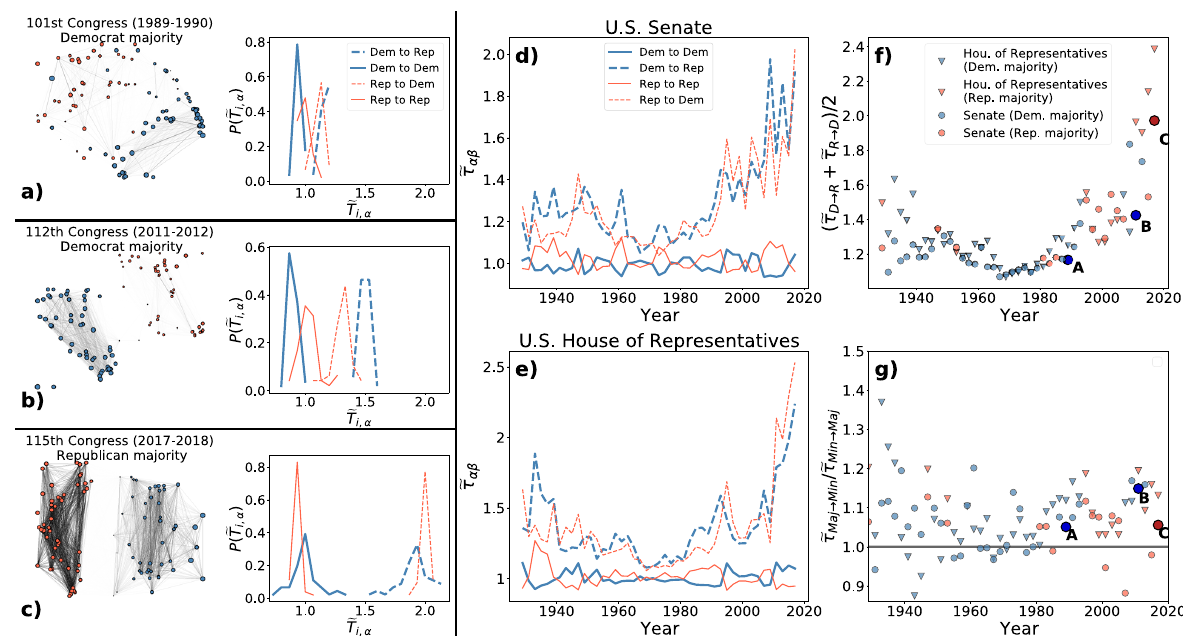
Fig. 5 Roll-call polarisation in the Senate and the US House of Representatives. a – c Three networks among the members of the Senate and the corresponding distribution of normalised class mean fi rst passage times (CMFPT) from the each node (member) i to each of the parties α . a 101st Congress (1989 – 1990), b 112th Congress (2011 – 2012) and c 115th Congress (2017 – 2018). Nodes correspond to republican (red) and democrat (blue) senators, while the width of each edge is proportional to the number of calls in which the corresponding two members voted the same. d – e Temporal evolution of the normalised CMFPT e τ αβ from class α to class β (in d the Senate and in e the US House of Representatives, respectively). f Temporal evolution of polarisation in the Senate and the US House of Representatives, as measured by ð e τ D þ e τ R Þ = 2 where D stands for Democrats and R for ! R ! D Republicans. Triangles correspond to the House of Representatives and circles to the Senate and their colour is set to red when Republicans hold the = e τ majority and blue when Democrats hold it. g Temporal evolution of e τ where e τ is the normalised CMFPT from the party holding the Maj ! Min Min ! Maj Maj ! Min majority to the minority one, while e τ Min ! Maj is the normalised CMFPT from the party in minority to the one holding the majority. The fact that this quantity is larger than one in most of the terms indicates that the party with a majority is the main driver of